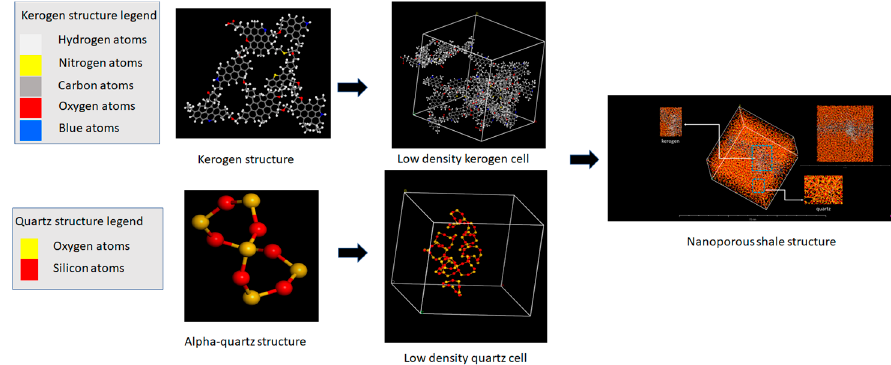
Figure 4. Construction of shale structures from kerogen and quartz macromolecules.